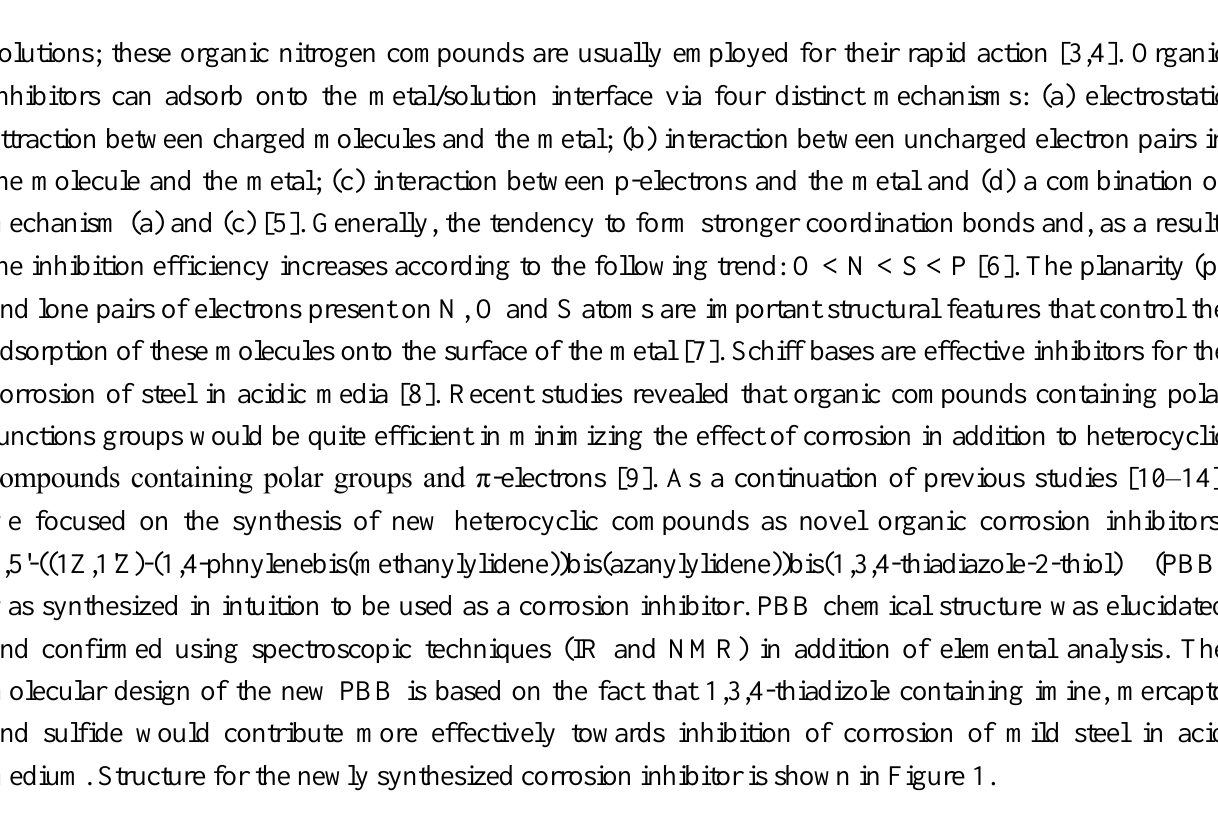
Figure 1. Structure of